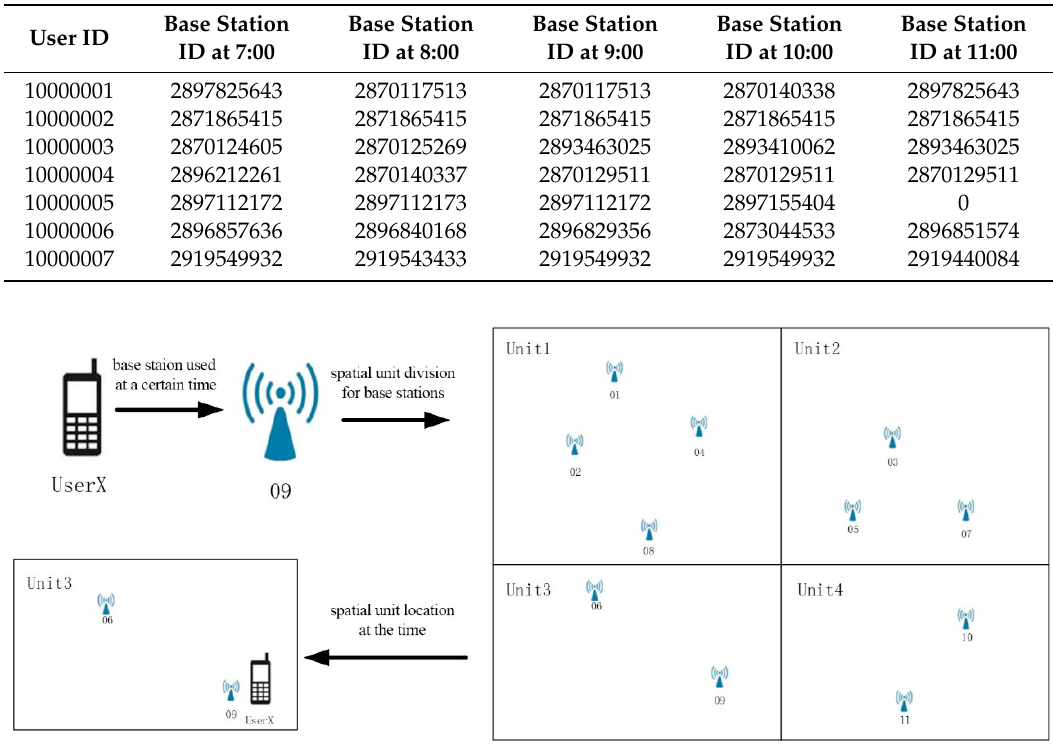
Figure 1. Procedures of assigning a user to a spatial unit.